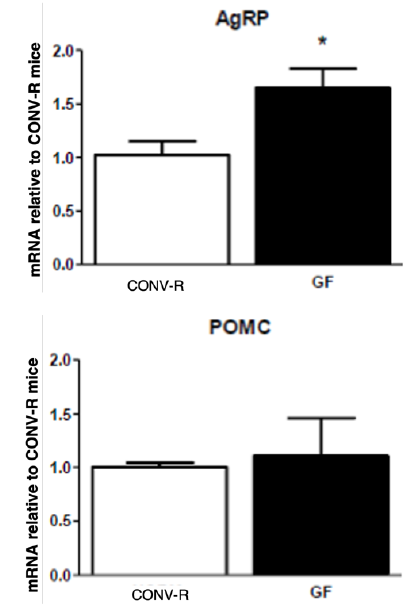
Figure 2. mRNA expression of NPY, AgRP, POMC, and CART in the hindbrain of GF and CONV-R mice after a 5-h fast. mRNA expression of GF mice is relative to the mean level of their CONV-R counterparts. Data are expressed as means ± SEM. * denotes statistical difference between GF and CONV-R, * p < 0.05.